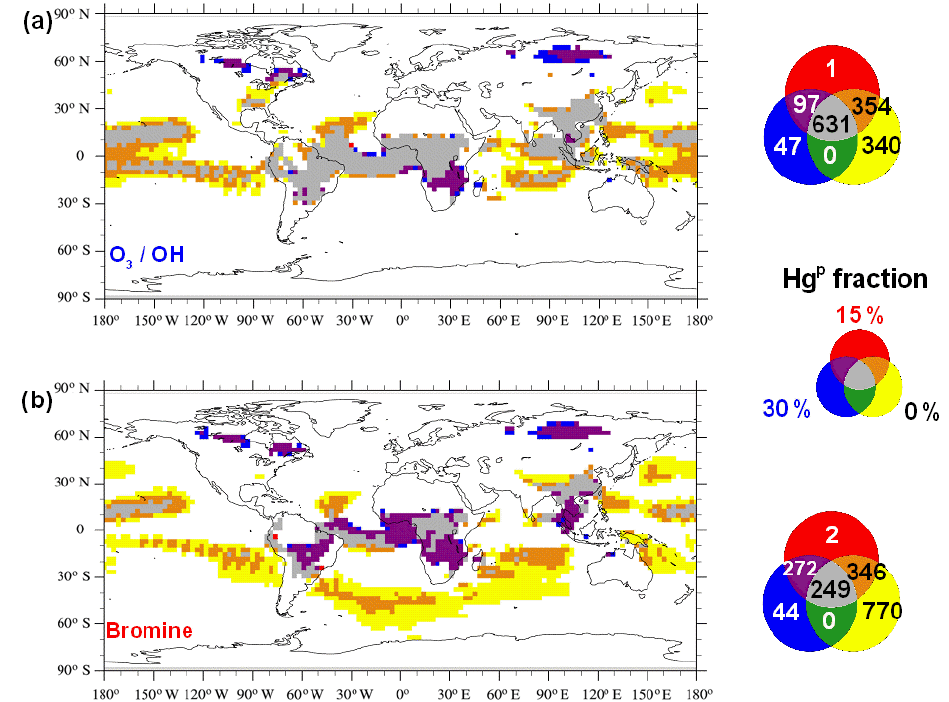
Figure 7. Agreement maps of high Hg deposition model cells obtained considering only BB emissions and assuming 0, 15 and 30% to be Hg P under both the oxidation mechanisms considered, O 3 / OH (a) and Br (b) . The maps show the areas where deposition is greater than µ + σ